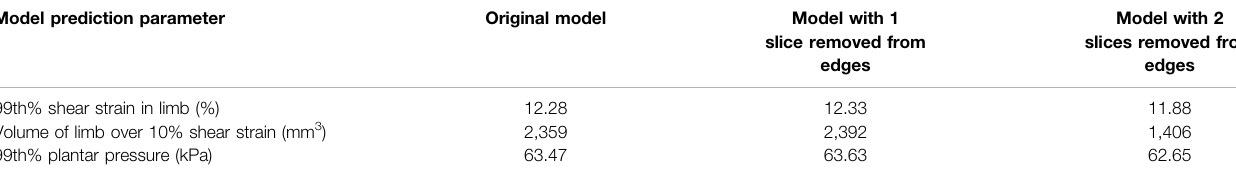
TABLE A2 | Results from the sensitivity analysis of removing coronal MR slices from the forefoot section